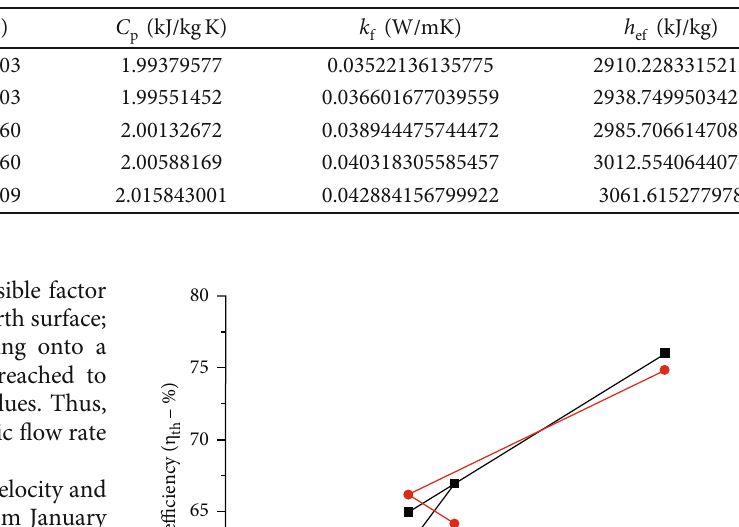
Table 5: Thermal properties of working fl uid at outlet temperature when p = 150 kPa.